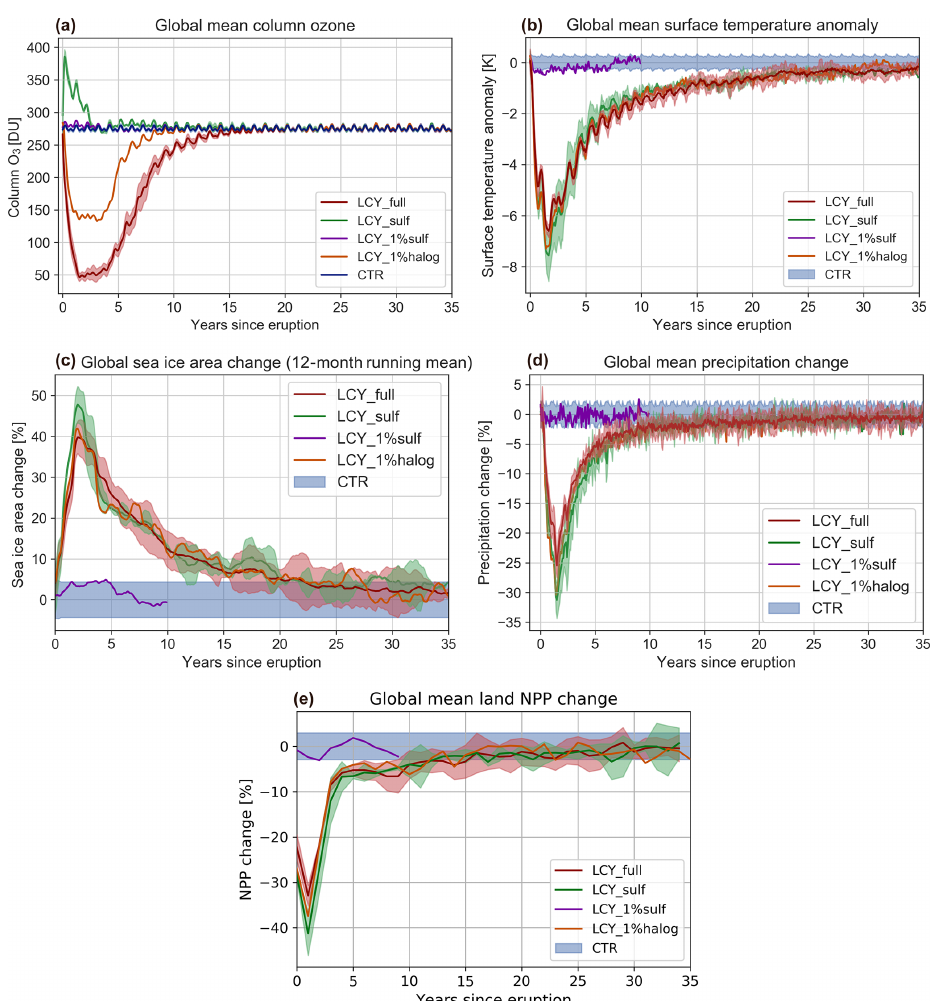
Figure 3. Global mean time series of column ozone (a) surface temperature anomalies (b) , sea ice area change (c) , precipitation change (d) , and annual mean net primary production (NPP) change (e) in the LCY simulation